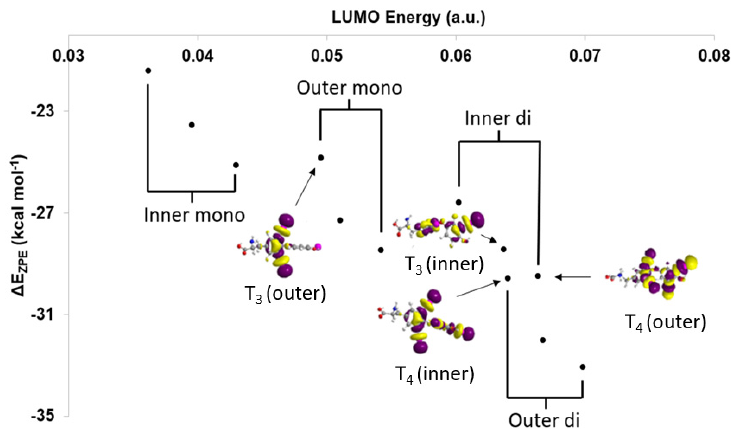
Figure 5. Comparison of lowest unoccupied molecular orbital (LUMO) energies with respect to Δ E ZPE and select LUMOs of the inner and outer rings of T 4 and T 3 . Adapted from reference [28].